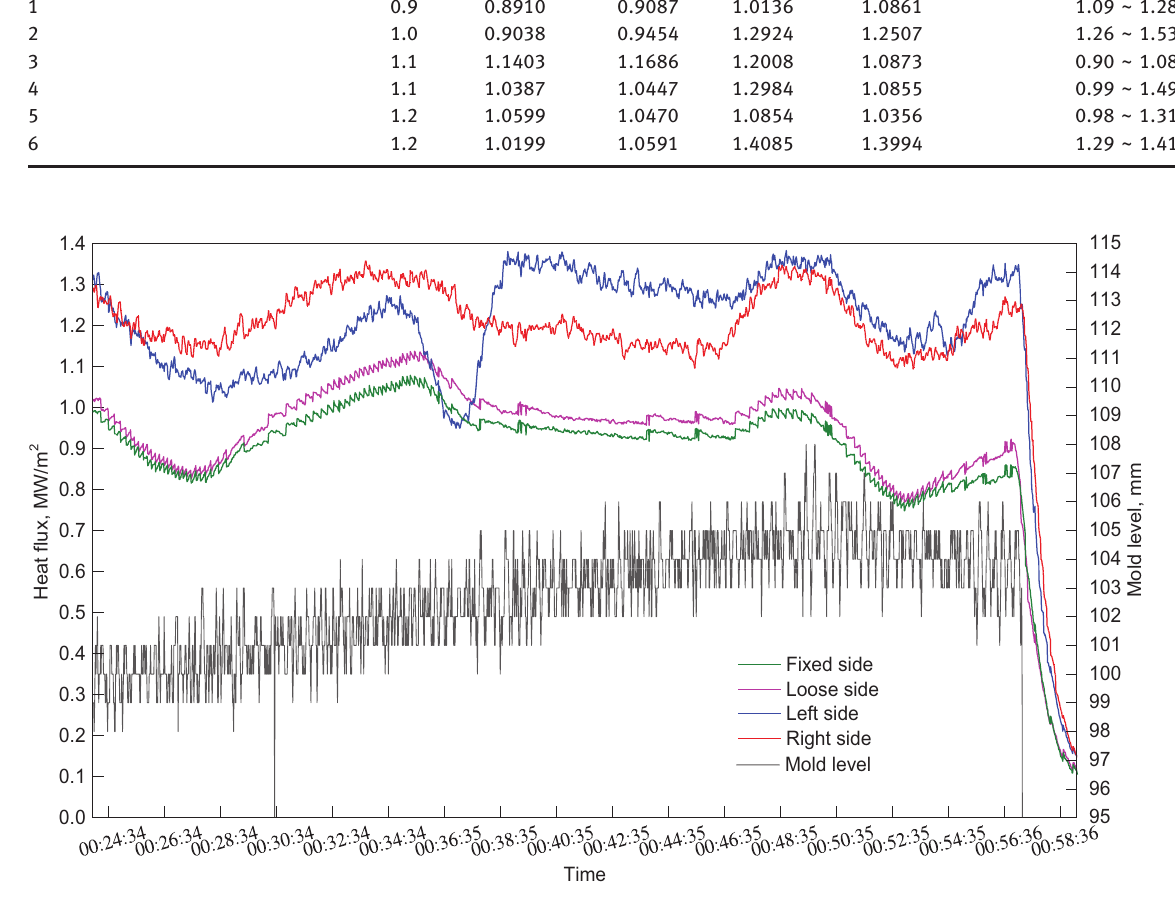
Figure 4: Heat flux variation of each face of the mold before breakout for sample